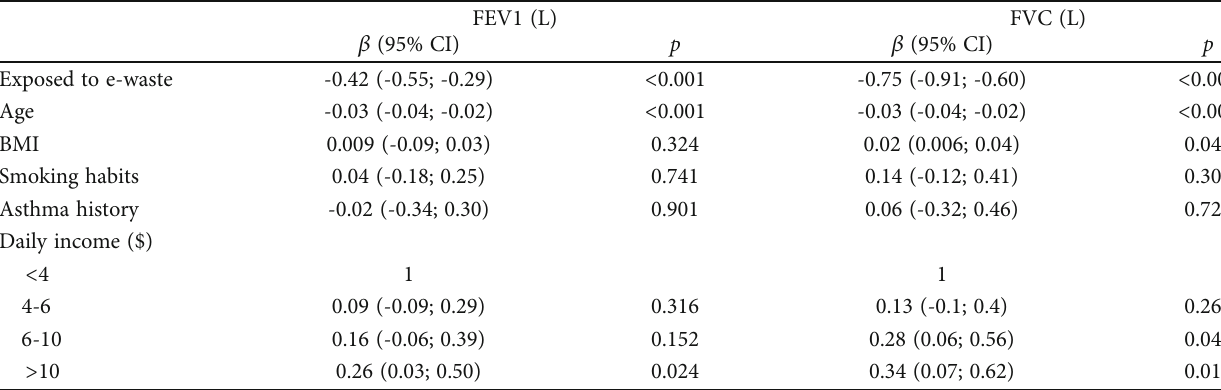
Table 5: E ff ect of estimated exposure to e-waste via handling work on FEV1 and FVC determined by multiple linear regression after adjustment on age, BMI, asthma history, and daily income in e-waste workers (exposed, n = 148 ) compared to matched unexposed subjects ( n = 148 ) in Cotonou, Benin ( N = 296